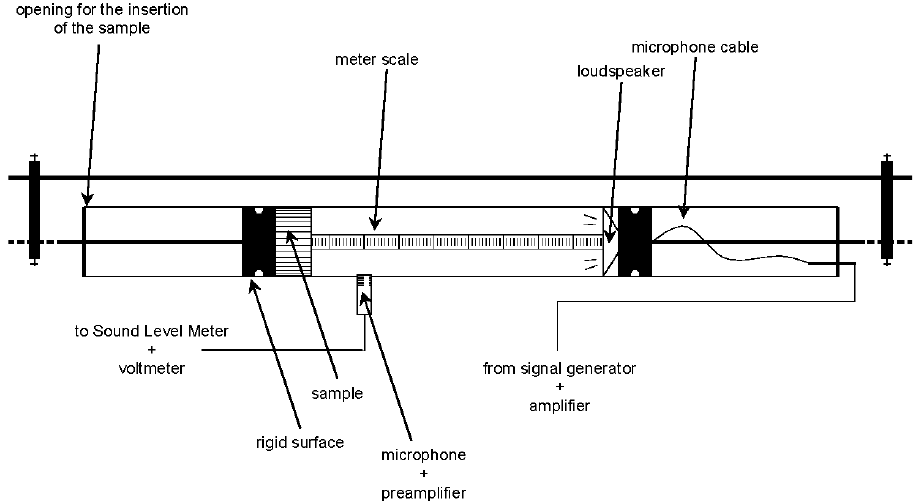
Figure 3: Horizontal standing wave tube with variable length